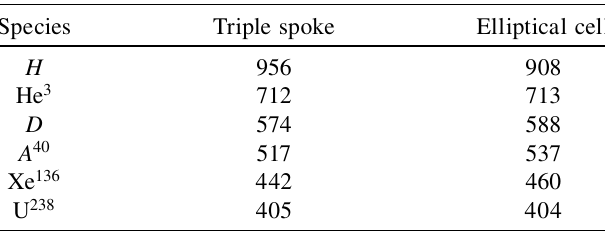
TABLE IV. Output beam energies ( MeV = nucleon) for several ion species for the two design